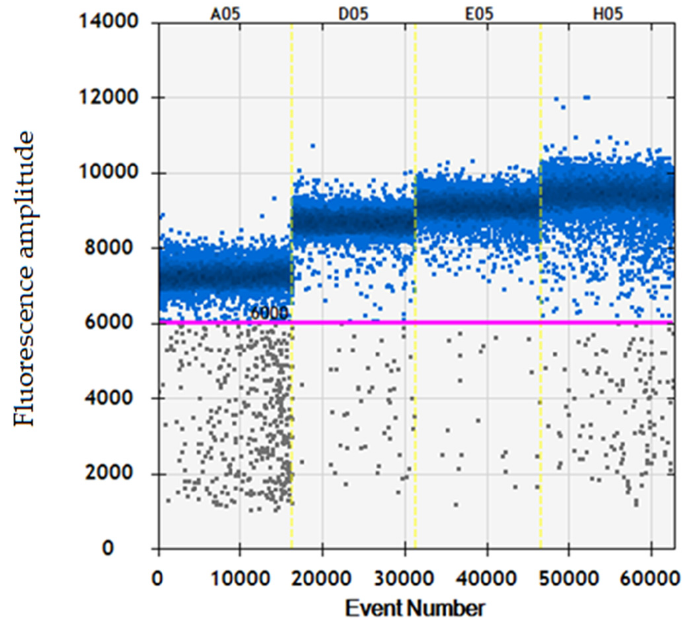
Figure 1. Fluorescence intensity plotted against annealing temperature gradient from 64 to 58 °C of a ddPCR assay for the quantitative determination of HDV-RNA in plasma samples. Annealing temperature were 64 °C in well A05, 61.7 °C in well D05, 60.3 °C in well E05, and 58 °C in well H05. The horizontal red line represents the threshold which establish a cut-off in the fluorescence intensity signal to differentiate between positive and negative droplets in a ddPCR assay. Each column depicts the negative (black) and positive (blue) events for single ddPCR well. Abbreviations: channel (Ch).